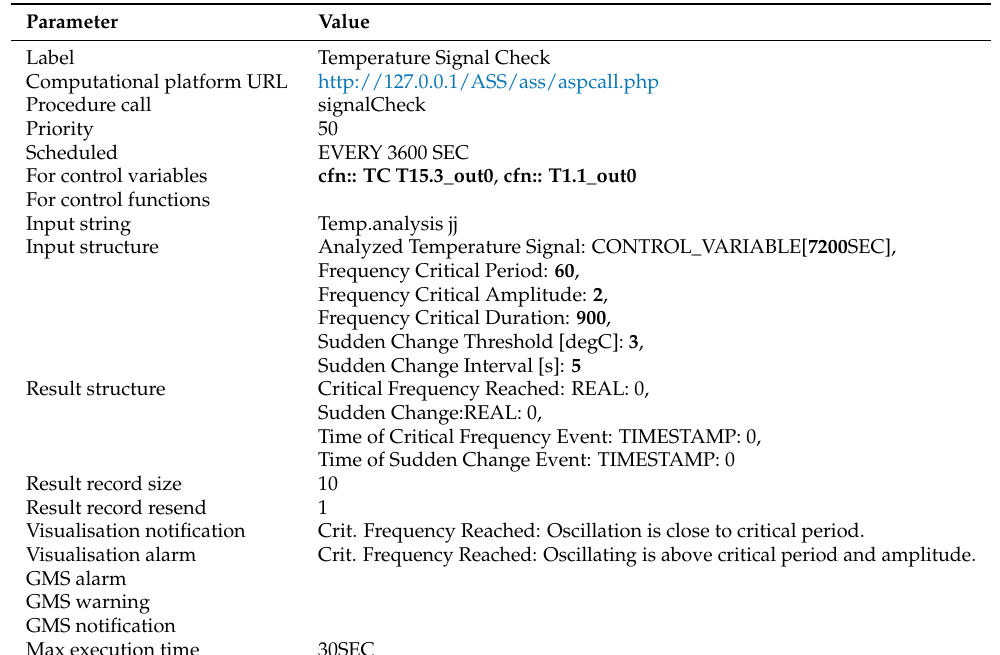
Figure 5. Visualisation accessible on any device with a web browser. A —mobile-phone; B —tablet; C —desktop; and, D —laptop. Table 1. Experimental setup for signalCheck()